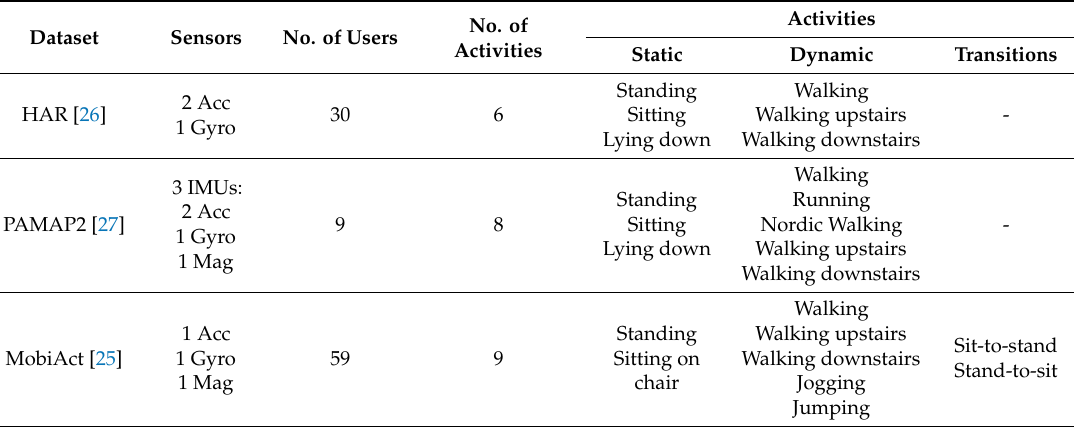
Table 1. Characteristics of the selected